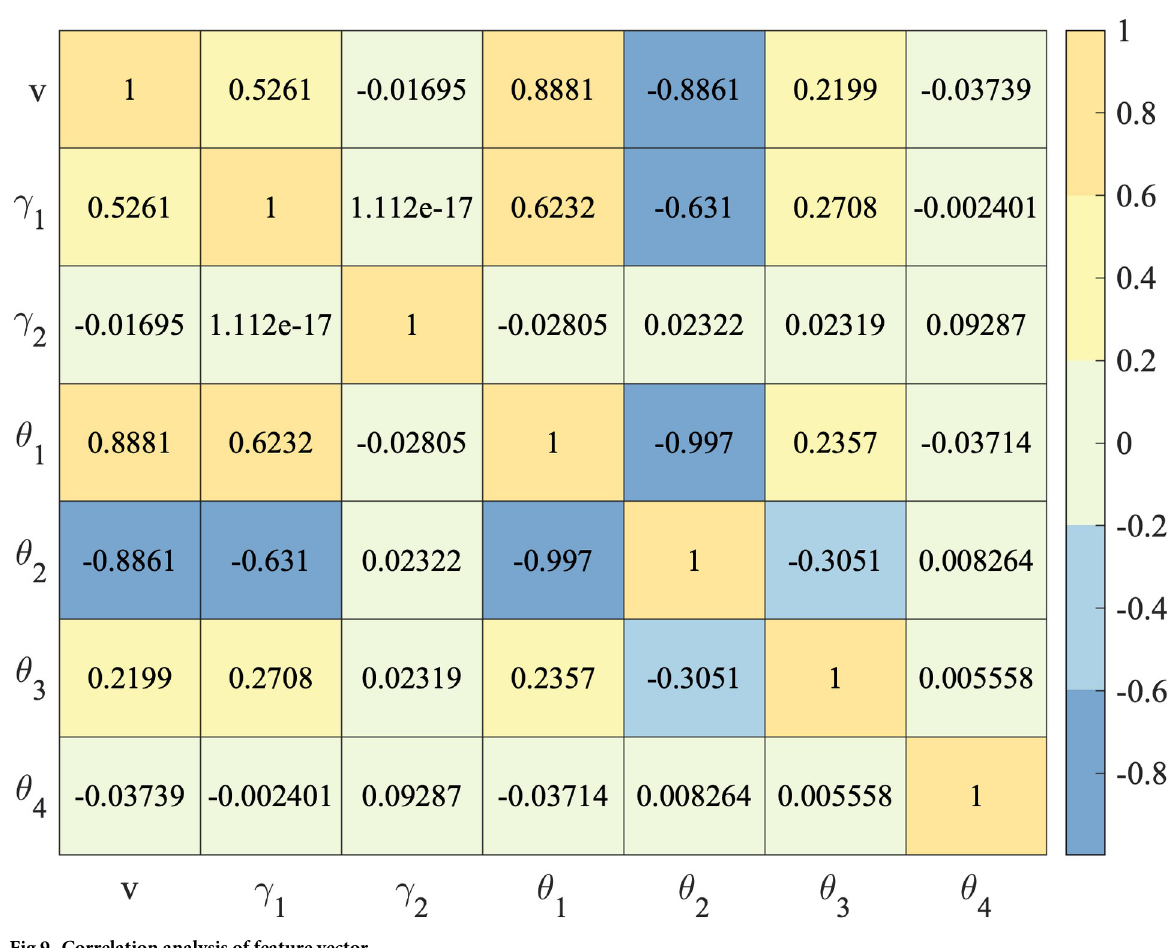
Fig 9. Correlation analysis of feature vector.